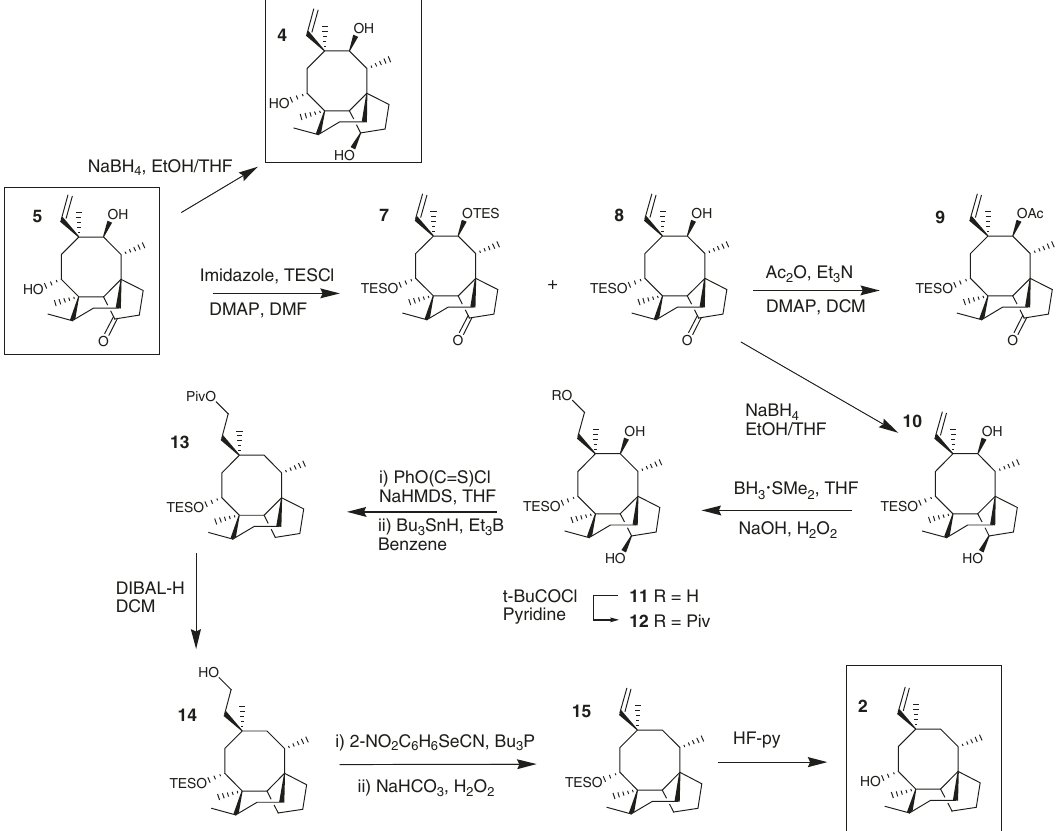
Fig. 2 Synthesis of proposed biosynthetic intermediates. Predicted biosynthetic intermediates 2 , 4 and 5 were prepared and used as standards to con fi rm the structures of the compounds produced de novo in A. oryzae in this